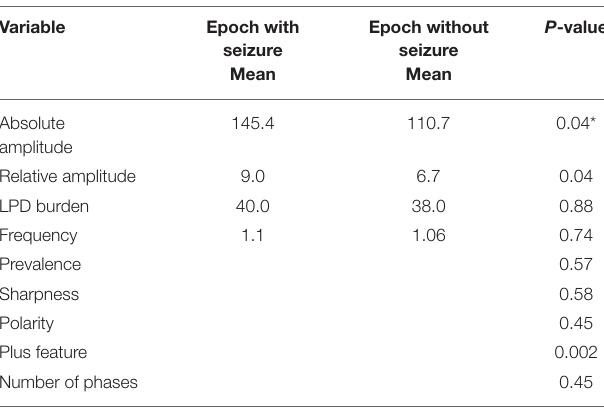
TABLE 3 | Comparison of LPD features between epochs containing seizures ( N = 23) and epochs without seizures ( N = 116) for all 20 patients. Variable